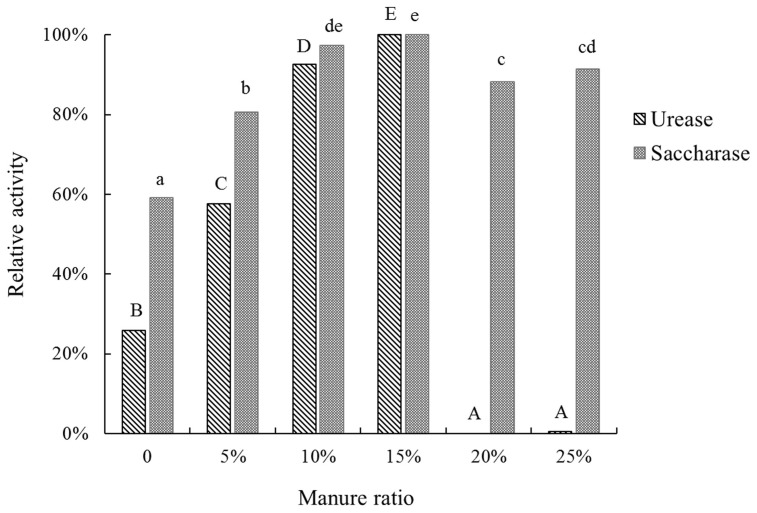
Urease and saccharase activities of soil with different manure ratios.Each enzyme's highest activity levels was defined as 100%. Different letters means significantly different at P<0.05, urease is represented as capital letters.